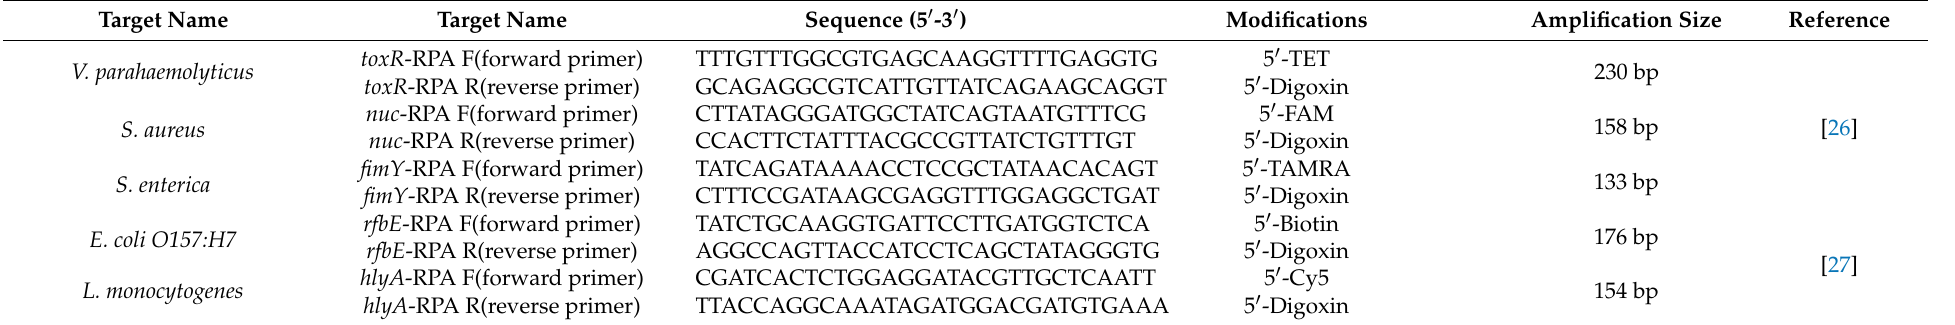
Table 2. Sequences of five foodborne pathogens for RPA